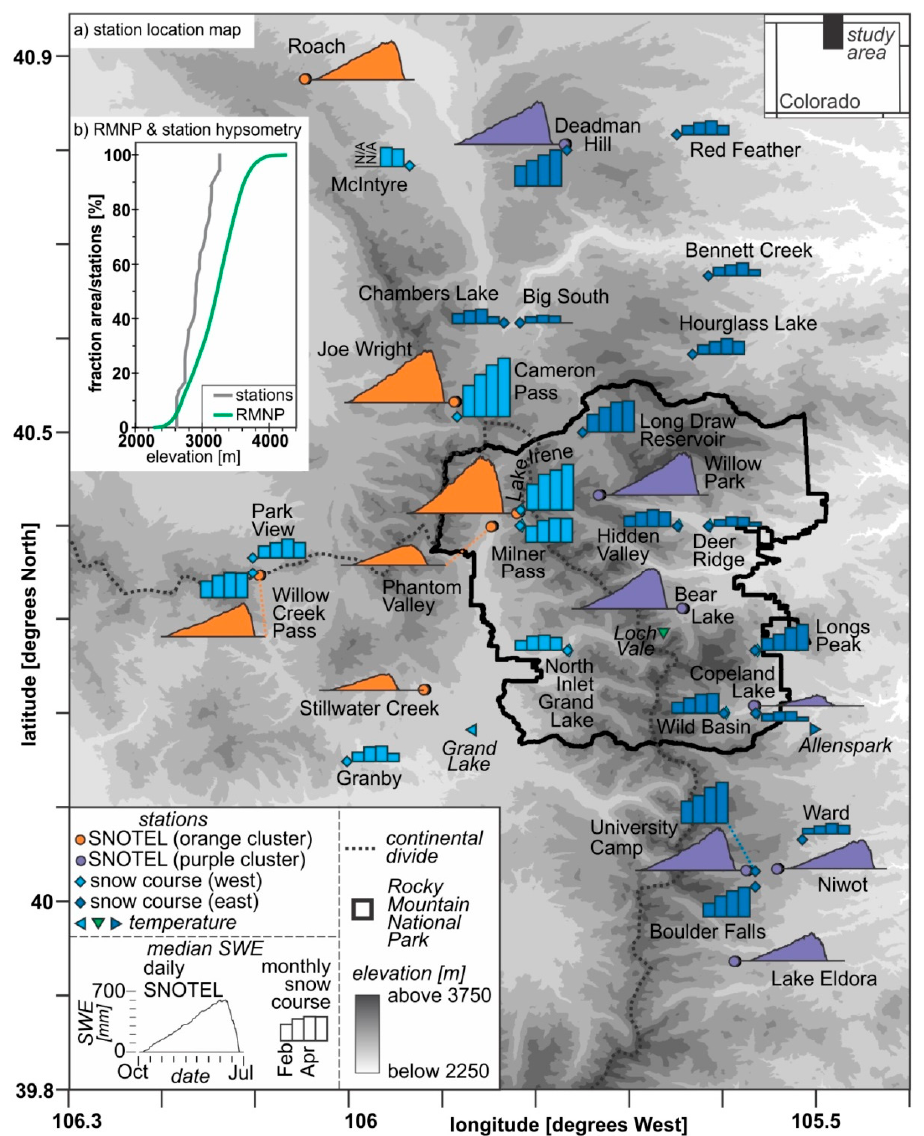
Figure 1. ( a ) Location of the study’s Snowpack Telemetry (SNOTEL) stations and snow courses in and around the Rocky Mountain National Park (RMNP) in north–central Colorado. The SNOTEL stations are shown with their 35 year (1981–2015) daily median niveographs, and snow courses with their monthly median niveographs. SNOTEL stations are denoted as circles in purple or orange as per the clusters of Clow [15], and snow courses are denoted as diamonds in light blue on the west side of the park and in dark blue on the east side of the park. The three temperature stations used in the study are denoted as green triangles. The top right inset shows the study site within the state of Colorado; the left inset ( b ) shows the hypsometry of all areas within the RMNP. Elevation data are from the 30 m digital elevation model obtained from the U.S. Geological Survey (https://nationalmap.gov/).